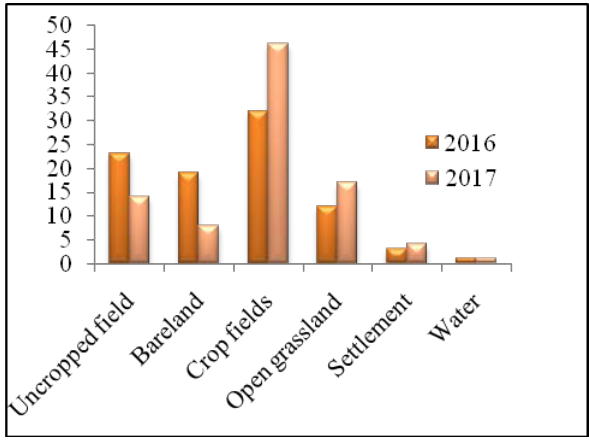
Figure 6: Comparison of the different classes over both seasons